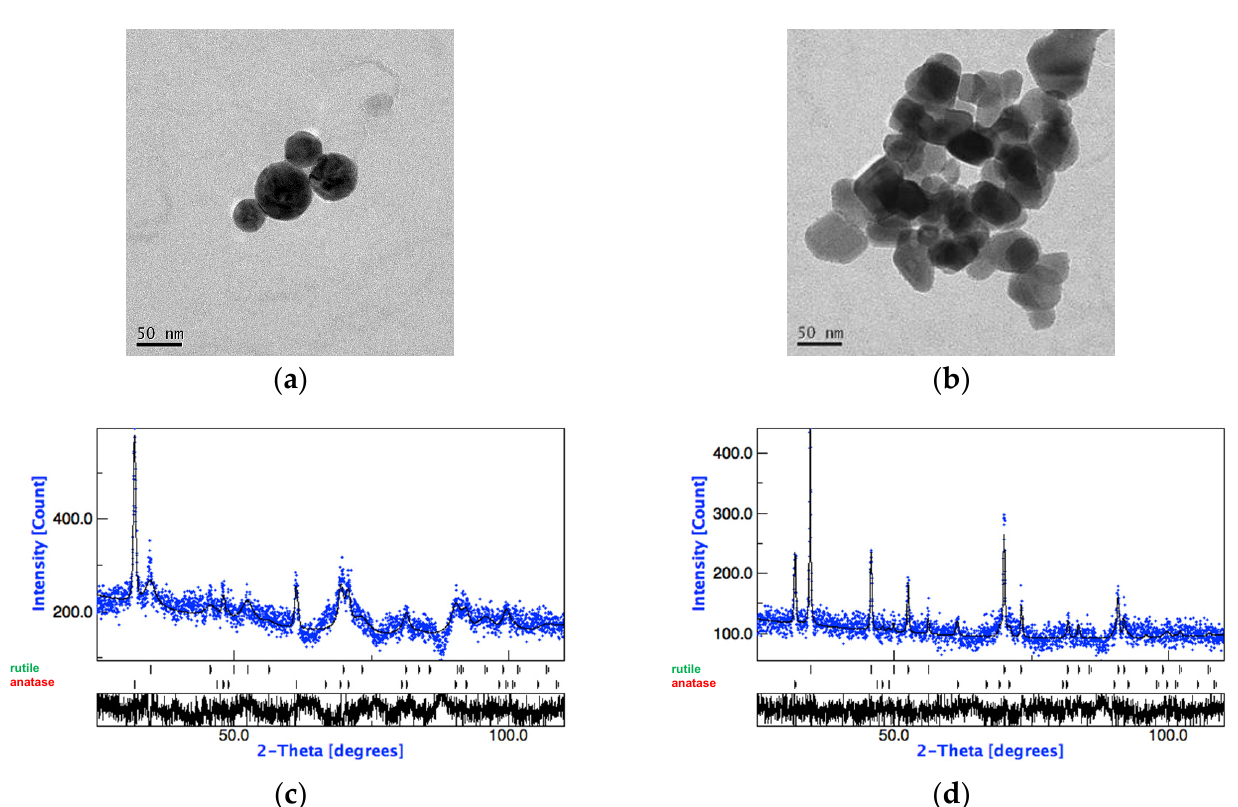
Figure 1. ( a ) TEM micrographs of TiO 2 -A and ( b ) TiO 2 -B NPs dispersed in water and deposited on a 300-mesh Cu grid coated with carbon film (bar 50 nm). ( c ) XRD pattern of TiO 2 -A: anatase: 79% and ϕ ≈ 45 nm, rutile: 21% and ϕ ≈ 6 nm; ( d ) XRD pattern of TiO 2 -B: anatase: 19% and ϕ ≈ 87 nm, rutile: 81% and ϕ ≈ 75 nm. Panel ( c ) related to TiO 2 -A has been previously published in [10] (Reproduced with permission from [10]. Copyright John Wiley & Sons, Ltd., 2014).